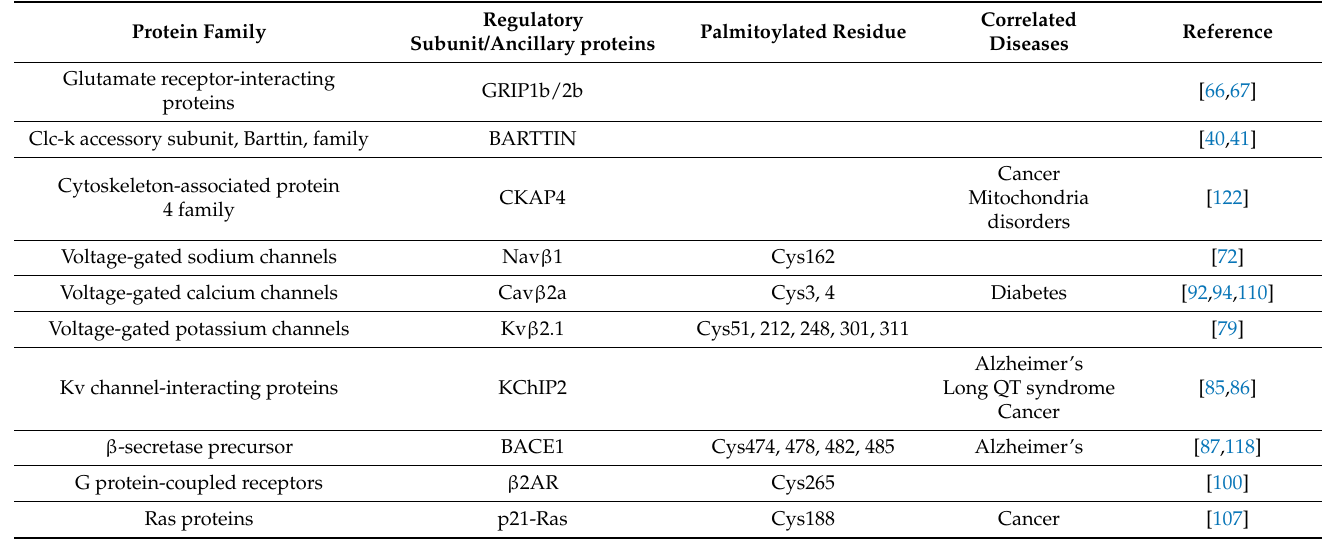
Table 2. Palmitoylated regulatory subunits and ancillary proteins and correlated